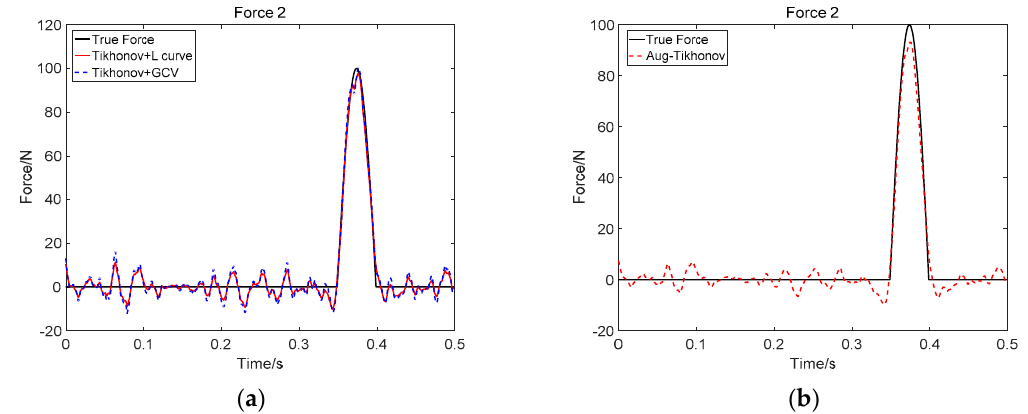
Table 3. Identification effect of two impact loads. SNR